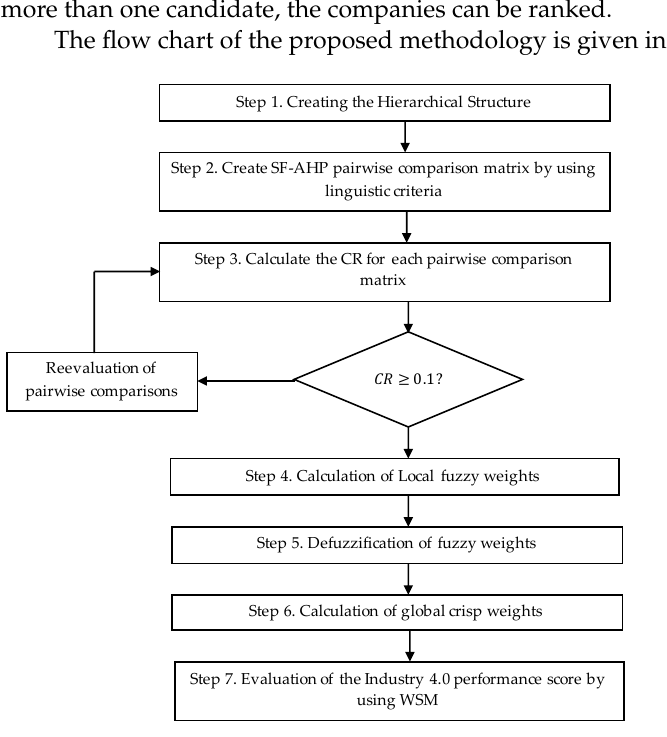
Figure 1. SF-AHP hieratical structure.